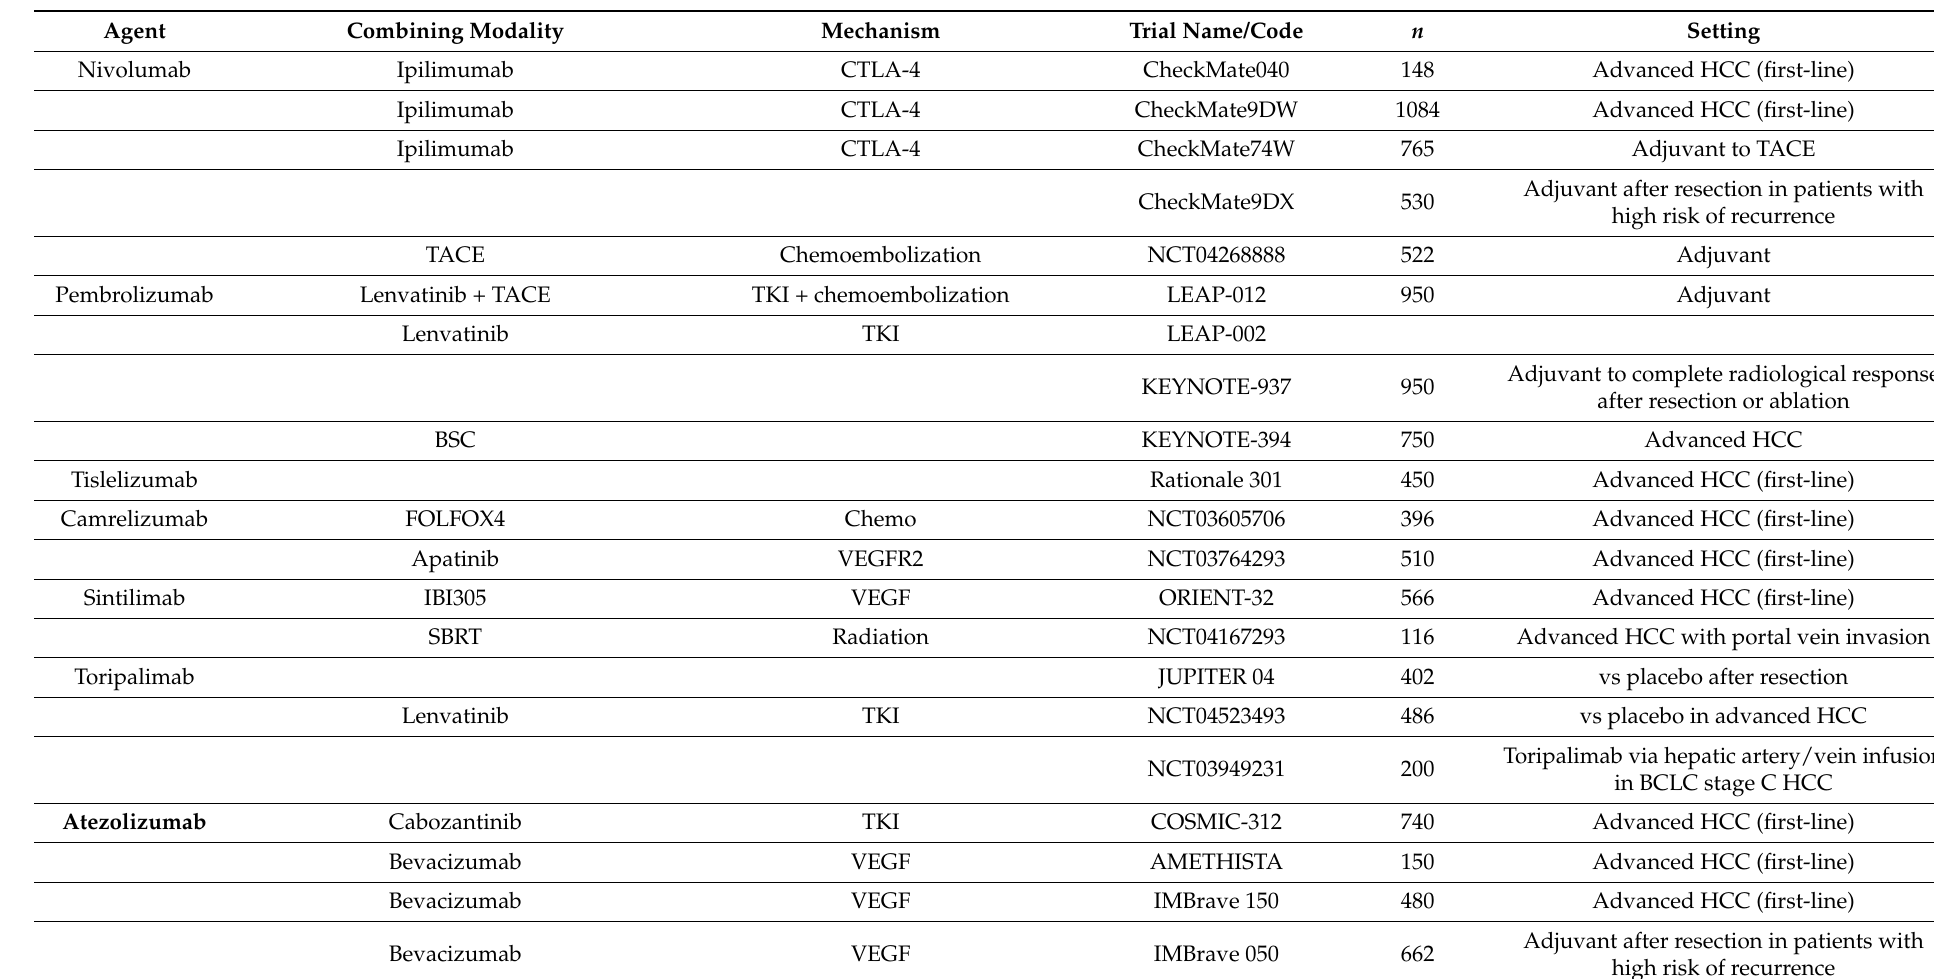
Table 2. Currently ongoing phase 3 trials with immune checkpoint inhibitors as monotherapy or in combinational setting in patients with